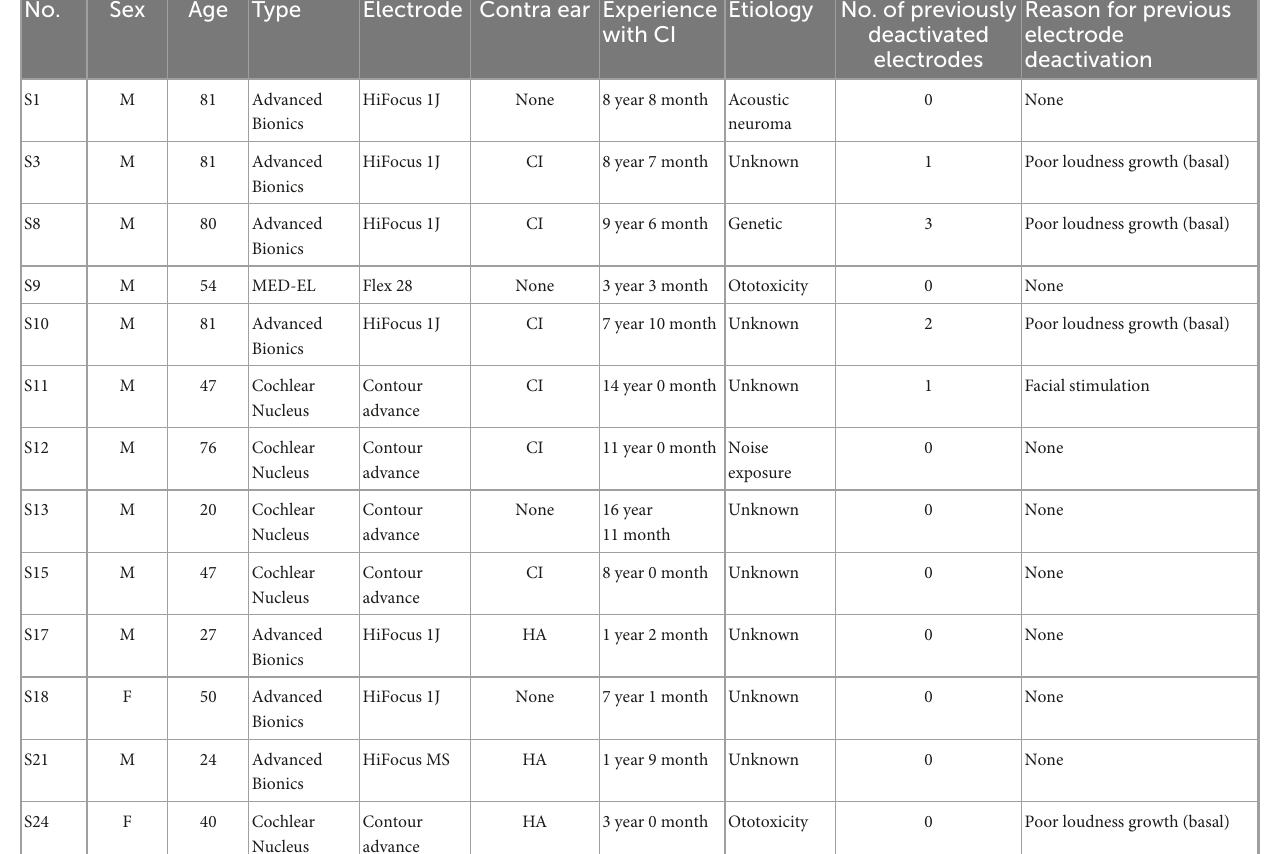
TABLE 1 Patient demographics and electrode deactivations upon enrolling in the study.